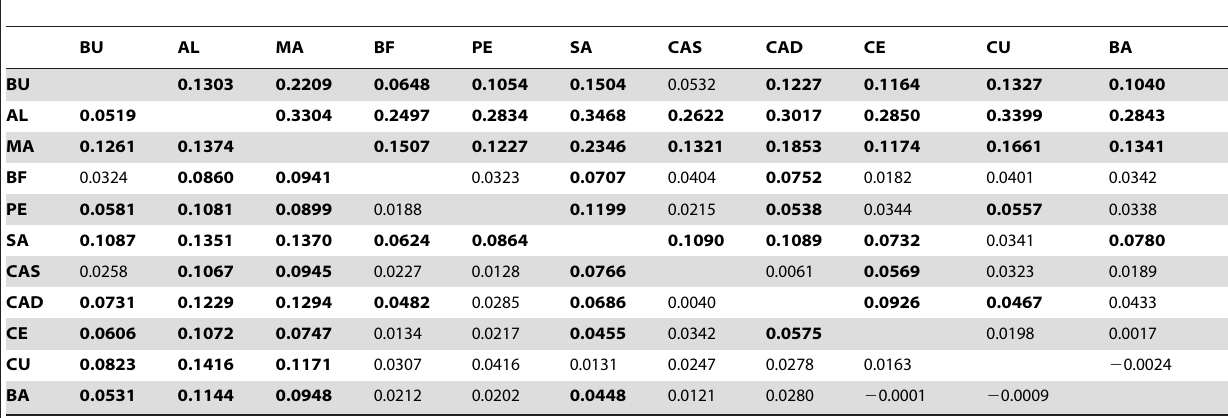
Table 2. Measures of genetic differentiation based on the microsatellite loci in pairwise comparisons of the studied populations of Microcosmus squamiger